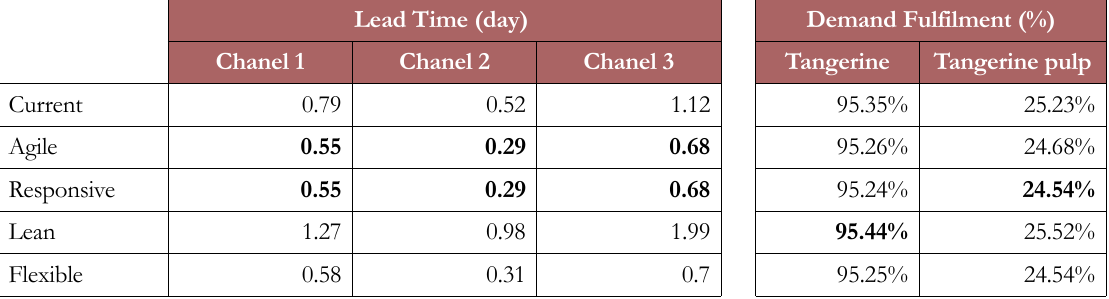
Table 4c. Leadtime and Demand fulfilment for